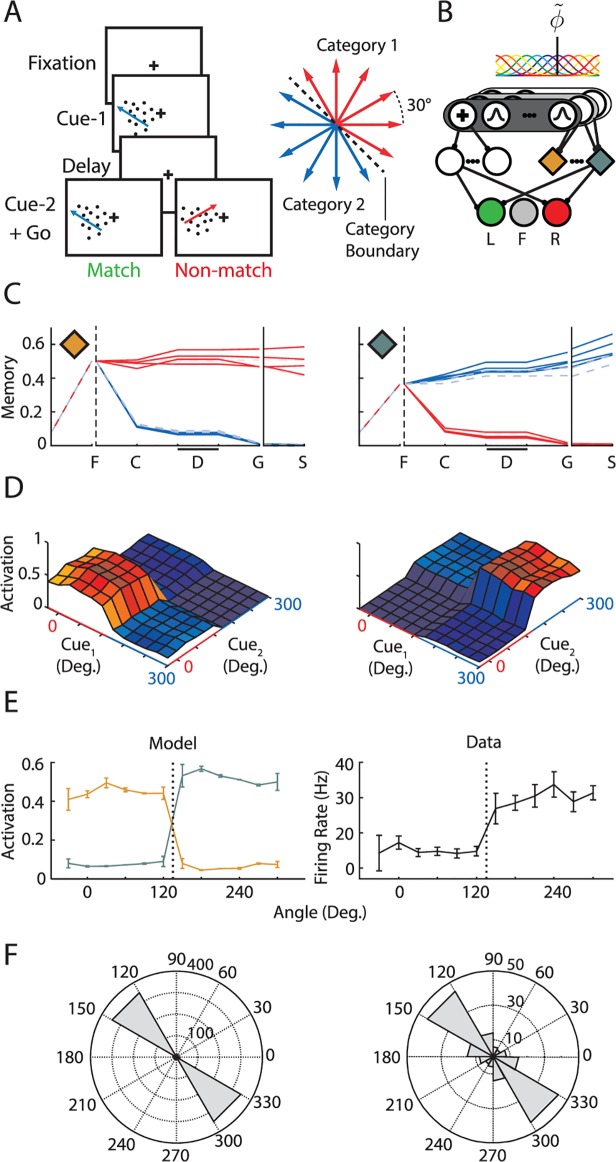
Match-to-category task.
A, When the network directed gaze to the fixation point, we presented a motion stimulus (cue-1), and after a delay a second motion stimulus (cue-2). The network had to make a saccade to the left when the two stimuli belonged to the same category (match) and to the right otherwise. There were twelve motion directions, which were divided into two categories (right). B, The sensory layer had a unit representing the fixation point and 20 units with circular Gaussian tuning curves (s.d. 12 deg.) with preferred directions evenly distributed over the unit circle. C, Activity of two example memory units in a trained network evoked by the twelve cue-1 directions. Each line represents one trial, and color represents cue category. Responses to cues closest to the categorization boundary are drawn with a dashed line of lighter color. F, fixation mark onset; C, cue-1 presentation. D, delay; G, cue-2 presentation (go signal); S, saccade. D, Activity of the same two example memory units as in (C) in the ‘go’ phase of the task for all 12x12 combinations of cues. Colors of labels and axes indicate cue category. E, Left, Motion tuning of the memory units (in C) at the end of the memory delay. Error bars show s.d. across trials and the dotted vertical line indicates the category boundary. Right, Tuning of a typical LIP neuron (from [4]), error bars show s.e.m. F, Left, Distribution of the direction change that evoked the largest difference in response across memory units from 100 networks. Right, Distribution of direction changes that evoked largest response differences in LIP neurons (from [4]).